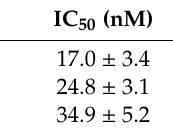
Figure 4. Kinase activity assays using microfluidic electrophoretic mobility shift assays (MMSA): Phosphorylation of a fluorescently-labeled substrate peptide by PKA-C α was monitored over a concentration range of inhibitor peptides 6 and 8 as well as PKI 1–24 . Both 6 and 8 were found to have IC 50 values that compare to the non-modified parent control, PKI 1–24 , thereby indicating that the introduction of a staple does not impair its inhibitory activity on PKA-C α . Table 3. Summary of microfluidic electrophoretic mobility shift assays (MMSA) analysis. Values were obtained from at least three independent measurements and are reported with SD.